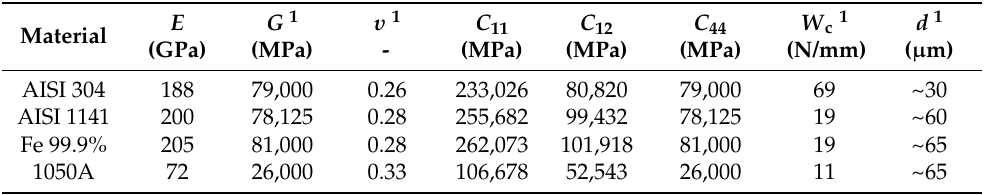
Table 3. CRSS values for different materials.